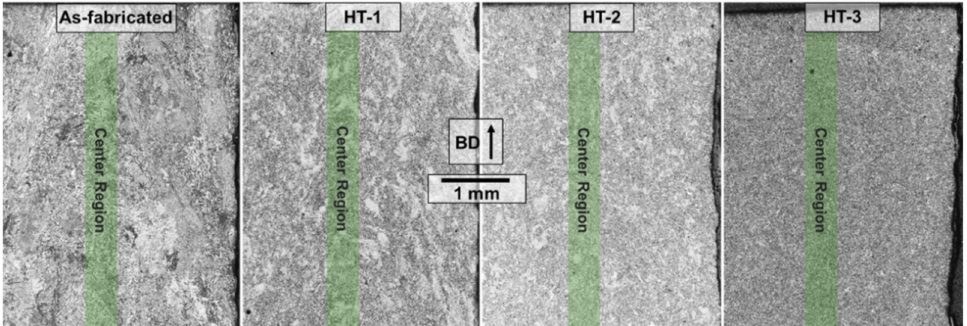
Figure 2. Optical micrograph of the “Side Bottom” location of each condition with the build direction from bottom to